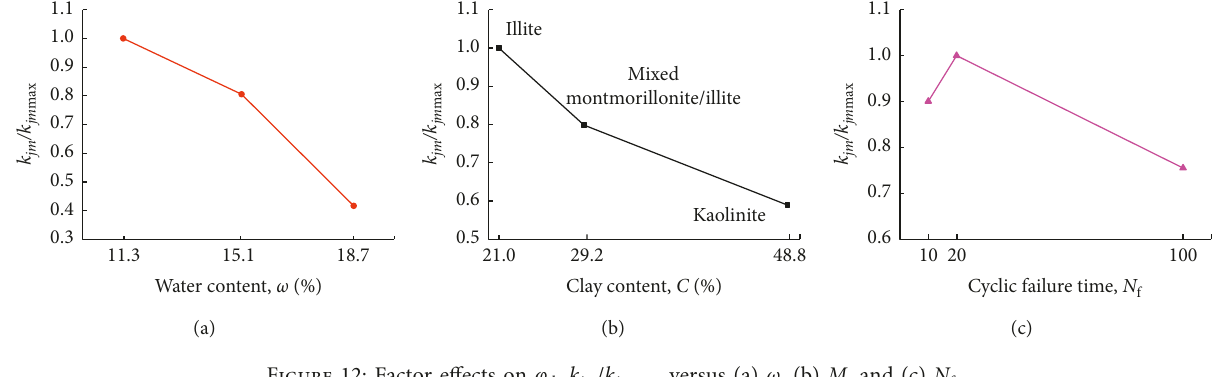
Figure 12: Factor effects on φ d . k jm / k jm max versus (a) ω , (b) M , and (c) N f .